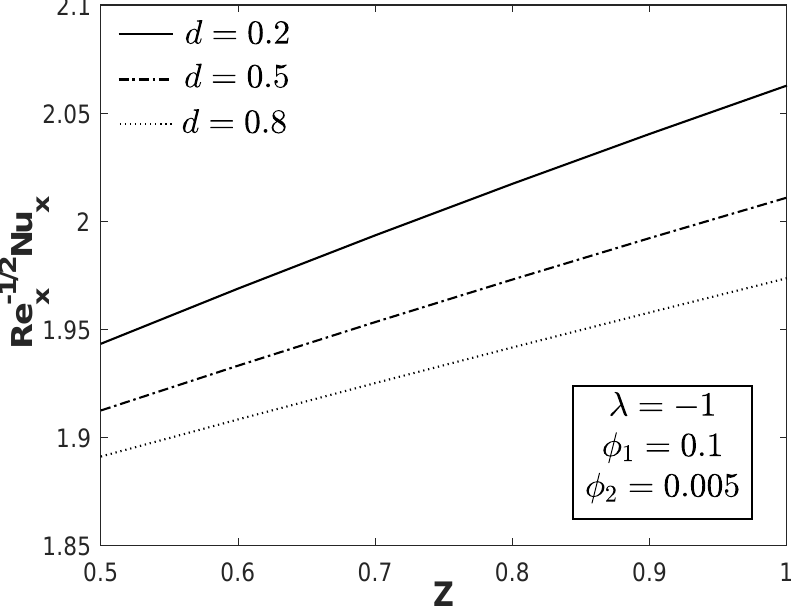
Figure 8. Re x − 1/2 Nu x towards Z with various d .